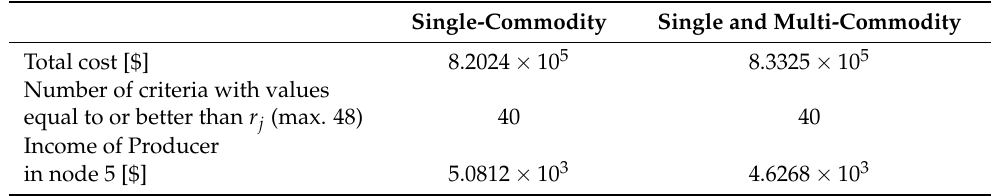
Table 5. Comparison of market indicators between single-commodity offers and single + multi- commodity.